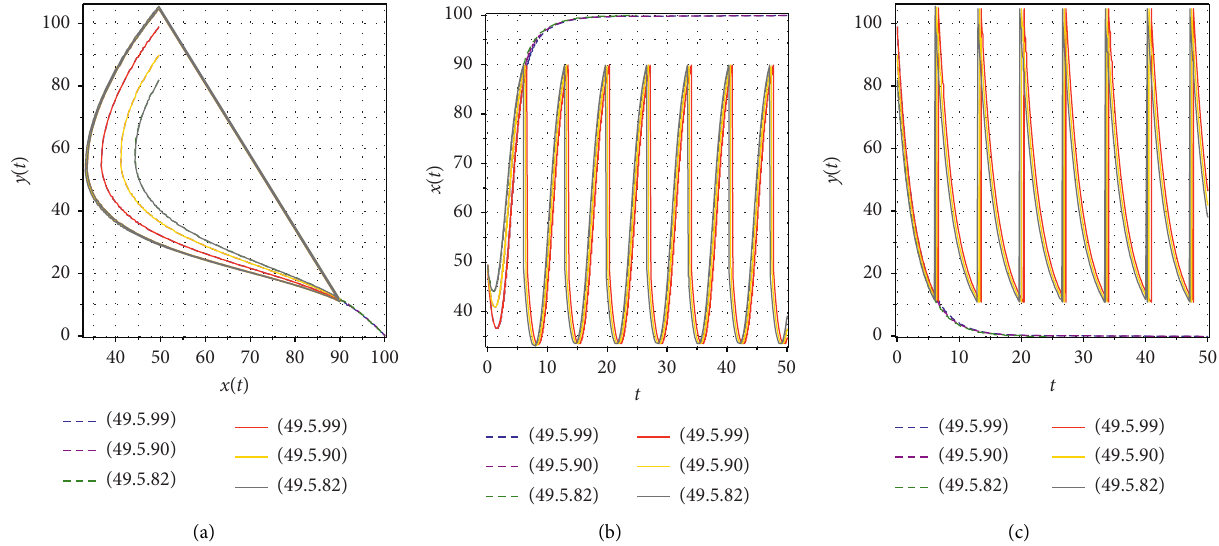
Figure 7: Numerical simulations when Φ ( y ) > y A A . (a) Phase portrait of x ( t ) and y ( t ). (b) Time series of x ( t ). (c) Time series of y ( t ). The solution of system (2) is presented in full line, and the solution of free system (1) is represented in dotted